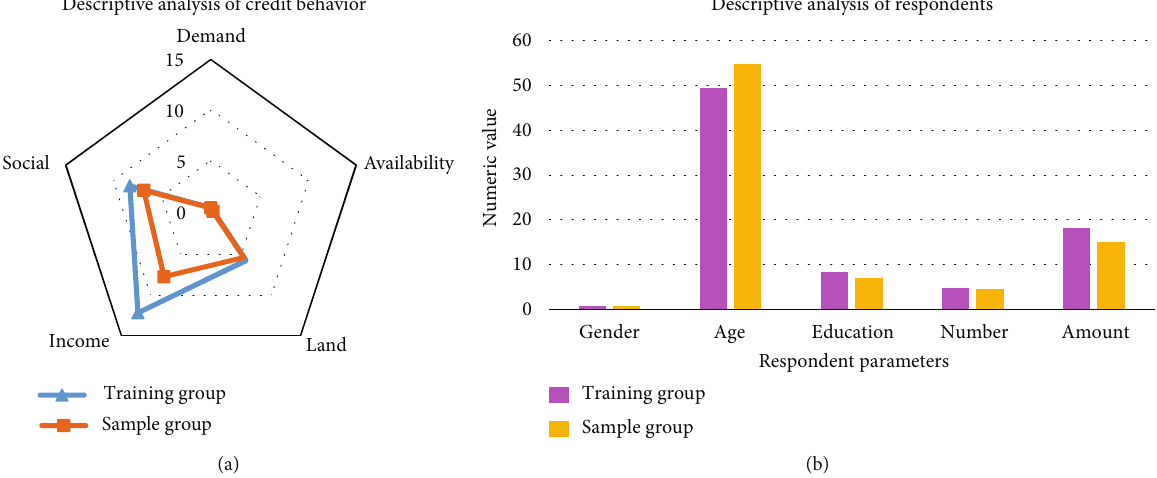
Figure 7: Descriptive analysis of herdsmen with high scores on emotional and psychological characteristics (a) distribution map of credit behavior; (b) identity map of respondents. Table 2: Graph of regression analysis results.